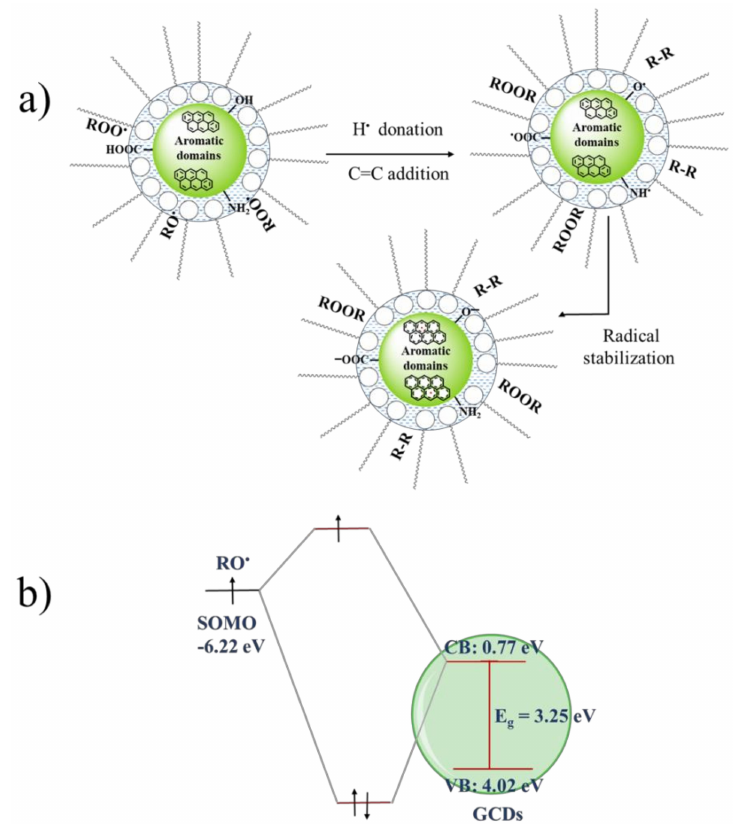
Figure 9. ( a ) Carbon dots antioxidant activity at the interface water-oil mediated by reverse micelles, ( b ) Frontier orbital interactions of singly occupied molecular orbital (SOMO) of the alkoxyl radical (RO • ) and the conduction band of